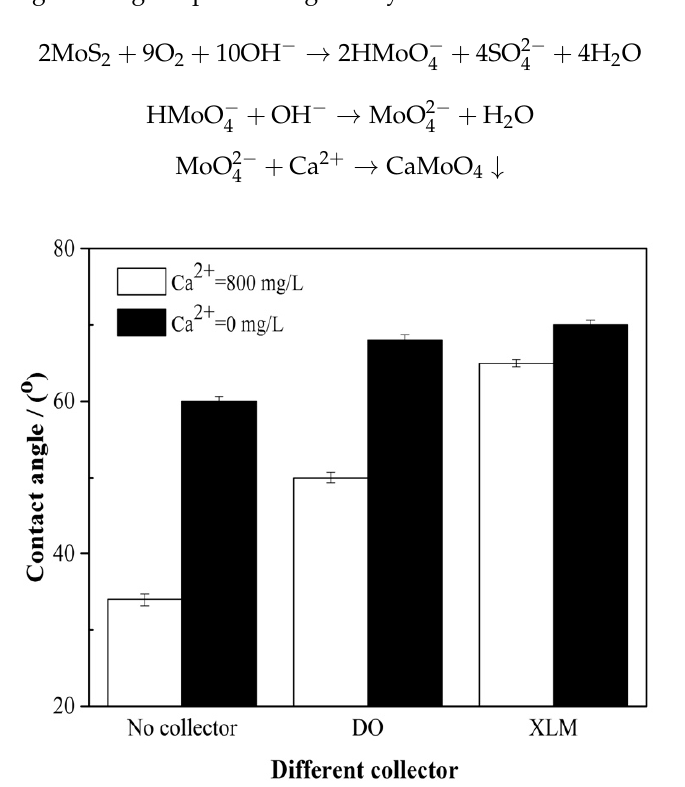
Figure 7. The contact angle of molybdenite in the absence and presence of XLM and diesel oil as a function of Ca 2+ concentration at pH 8.